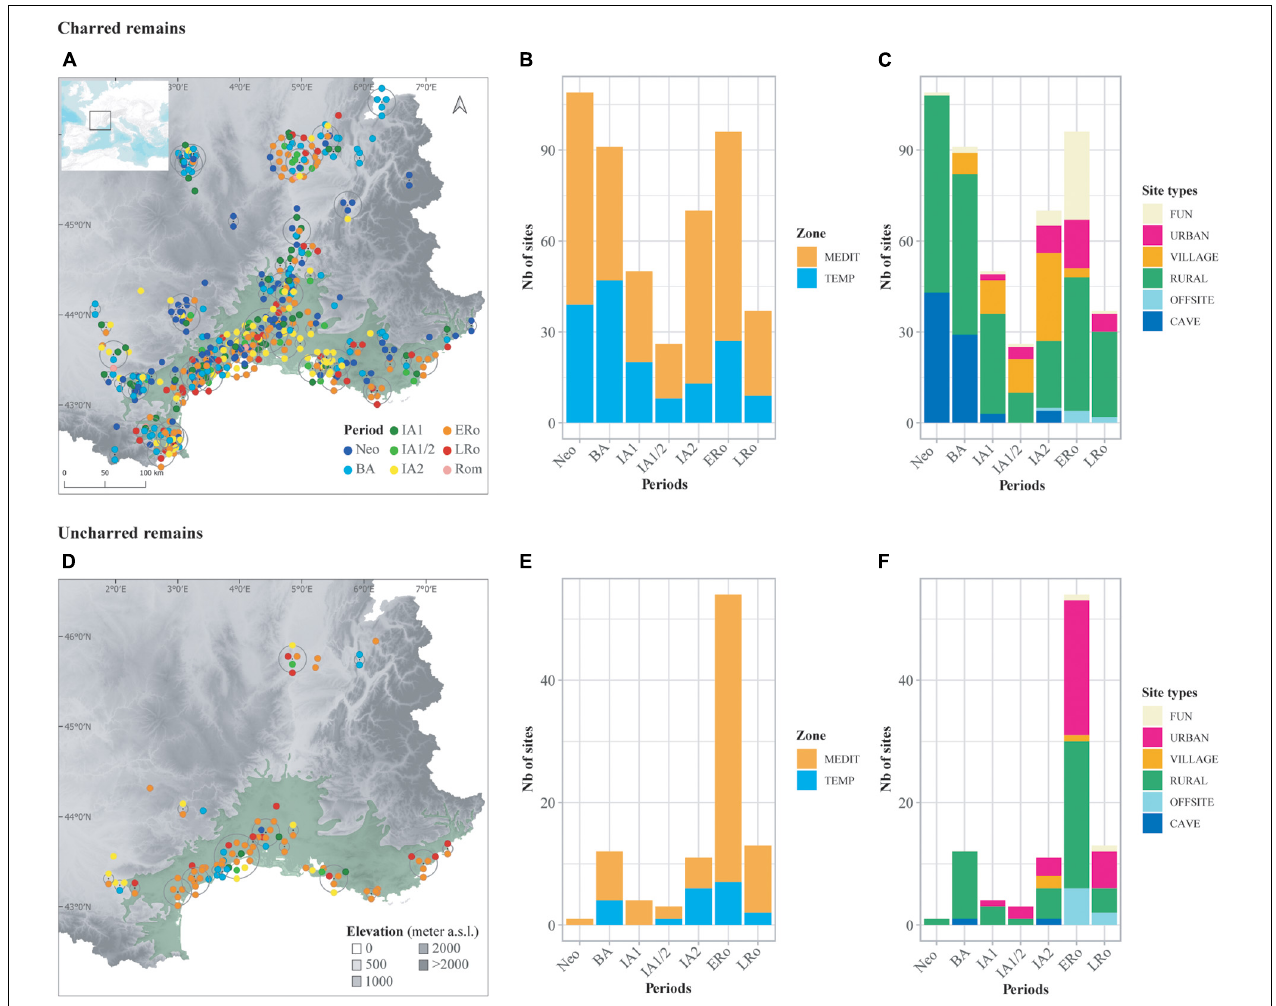
FIGURE 1 | Distribution of the archeological sites included in the database according to type of preservation of plant remains, charred and uncharred remains. (A,D) Maps showing site location; color of symbols corresponds to period of site occupation. The distribution area of the olive tree (Leguédois et al., 2011) is represented (in light green) as the limit of the Mediterranean bioclimatic zone. Topography is derived from the BDAlti 250 m of IGN. The map was created using QGIS version 3.16. To visualize all overlapping points, symbols are distributed in a circle around the central point (QGIS Point displacement Renderer). (B,E) Bar plots showing the distribution of sites in relation to chronology and bioclimatic zone. (C,F) Bar plots showing the distribution of sites in relation to chronology and broad site